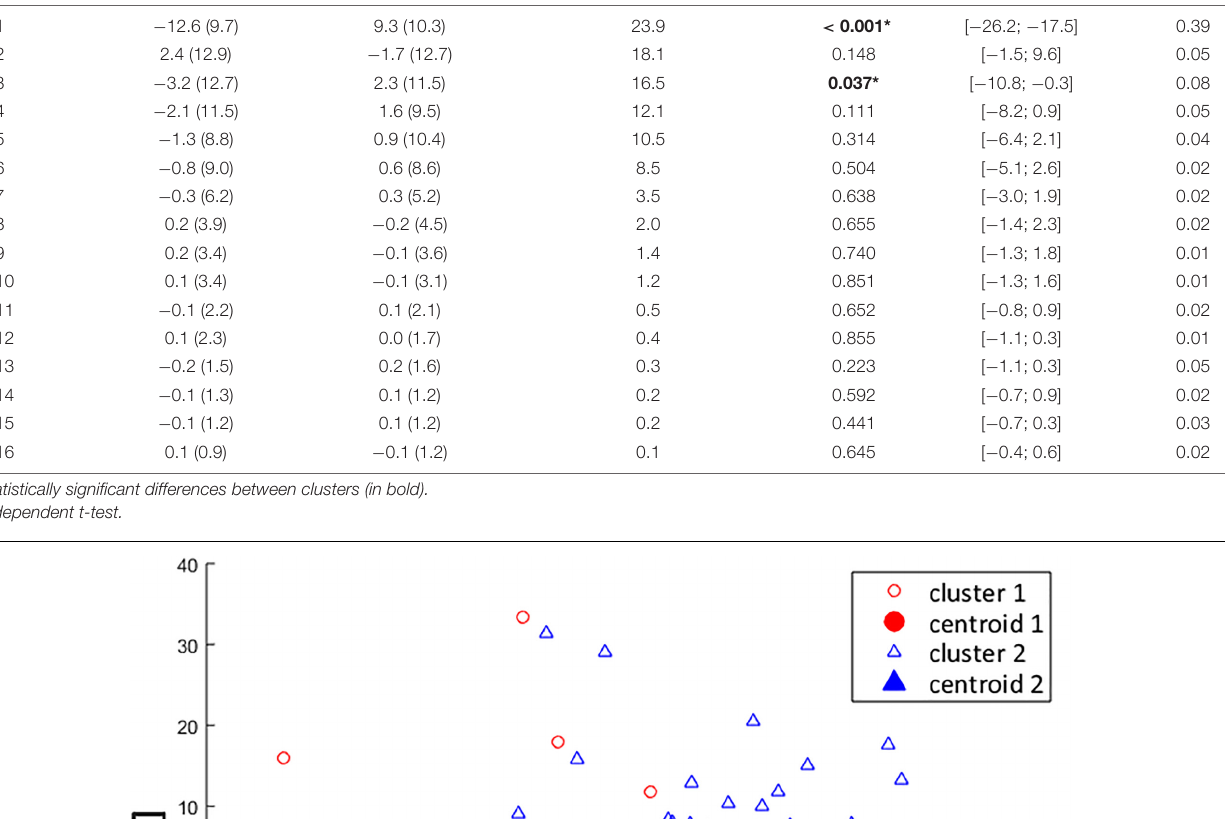
Differences in FA Movement Patterns The qualitative analysis of FA movement patterns across clusters was based on PC1 and PC3. However, since PC1